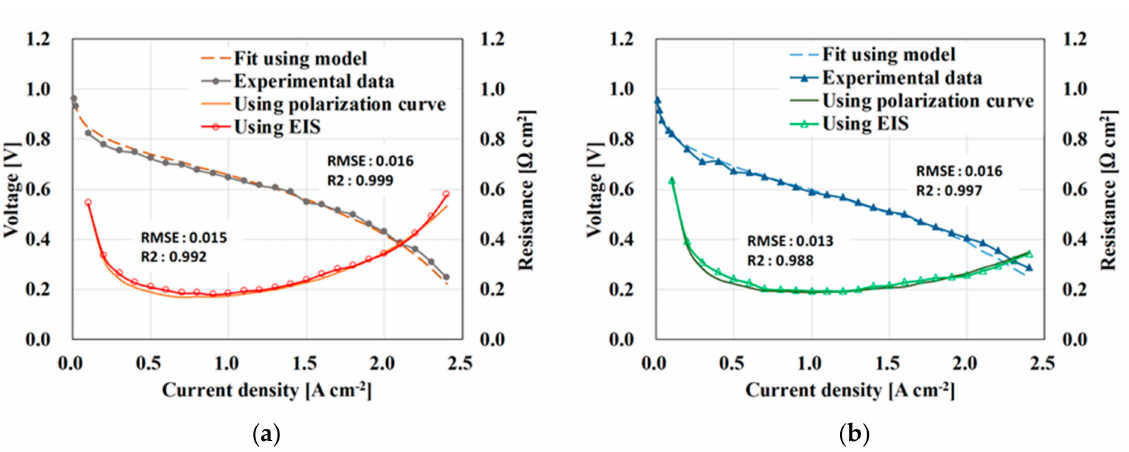
Figure 5. Polarization curves and total resistances at ( a ) RH 100%, ( b ) RH 80% under H 2 /air experiments. The experimental data of polarization curves were fitted using semi-empirical model. The total resistances using electrochemical impedance spectroscopy (EIS) were matched with the total resistances using polarization